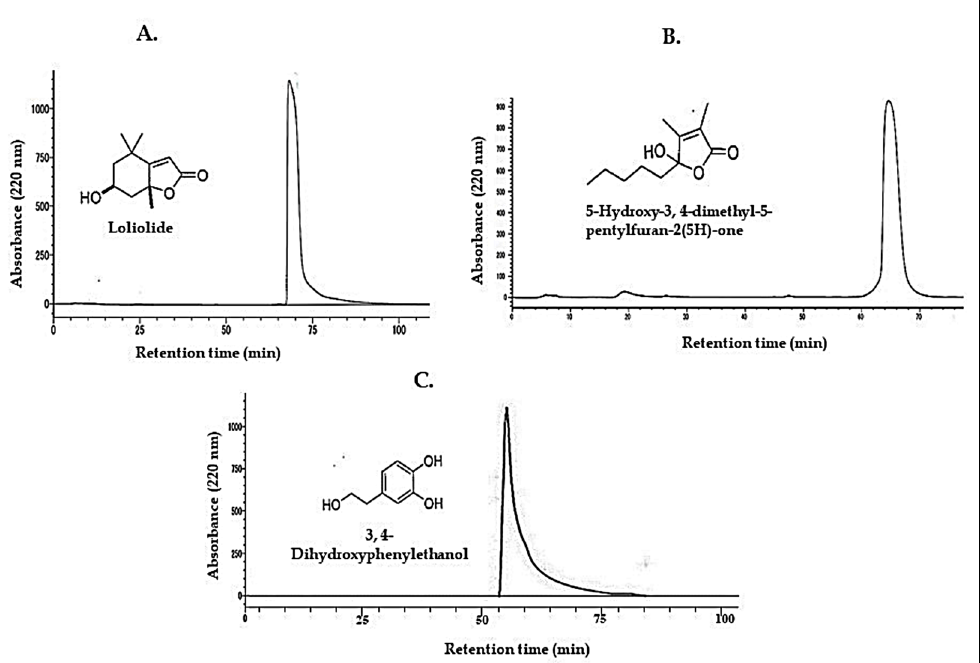
Figure 4. The chemical structure and chromatogram of the compounds loliolide (67–85 min) ( A ), 5-hydroxy-3,4-dimethyl-5-pentylfuran-2(5H)-one (62–72 min) ( B ), and 3,4-dihydroxyphenylethanol (49–65 min) ( C ) identified from A. reticulata leaf extracts eluted with 25%, 50%, and 8% ( v / v ) aqueous methanol by reverse-phase HPLC (4.6 I.D. × 250 mm; Inertsil ODS-3, HP 3 μm; GL Sciences Inc., Tokyo, Japan), at the flow rate of 0.5 mL/min and a 220 nm wavelength.